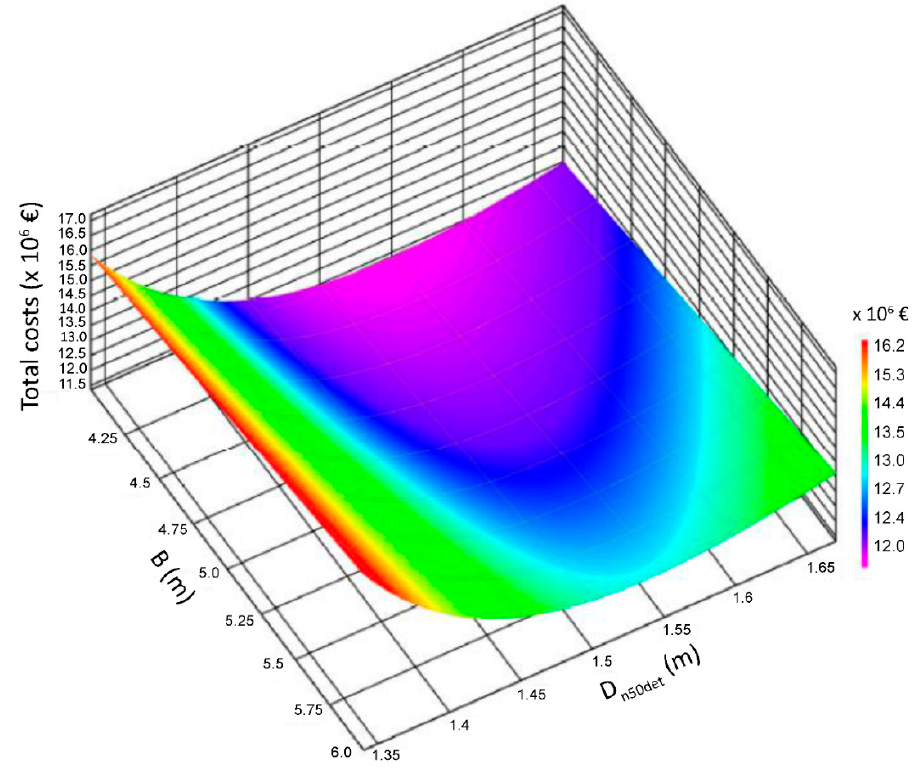
Figure 15. Total costs ( € ) as a function of the crest width, B (m), and the mean nominal diameter of rocks, D n 50det (m), for the detached low-crested structure of R cdet = − 0.5 m.